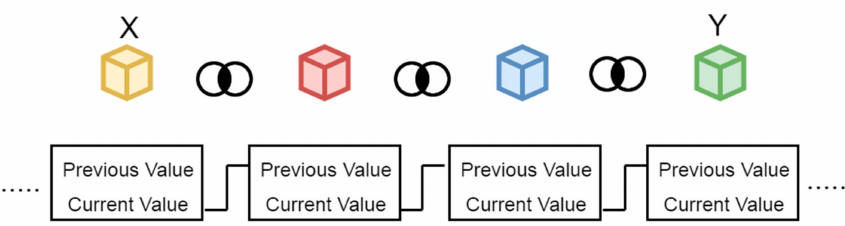
Figure 5. Consent through the blockchain among provider and ride requester.